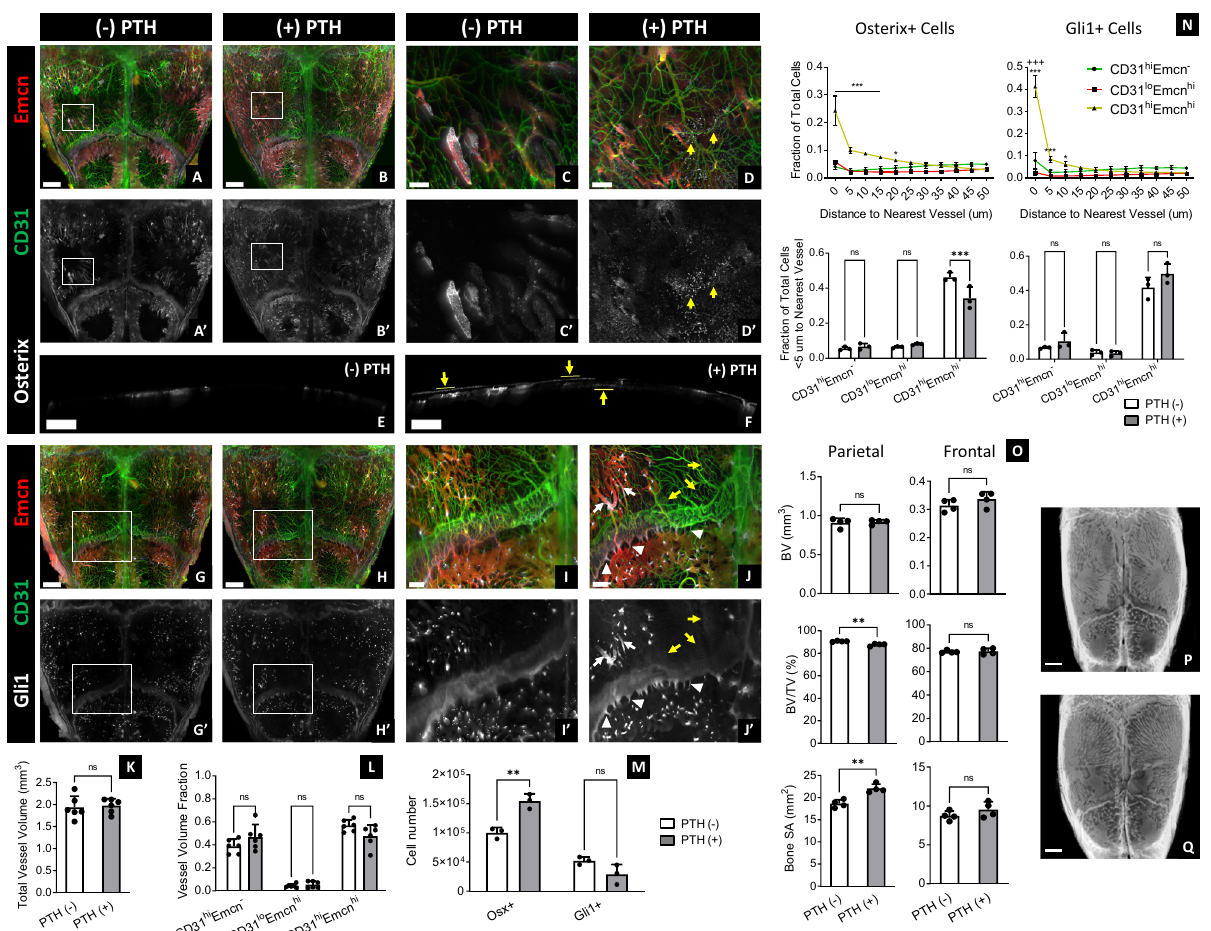
Fig. 4 PTH administration increases the number of Osterix + progenitors, but does not signi fi cantly affect Gli1 + progenitor number or CD31 hi Emcn hi vessel volume. A – D MIP of calvarial vessels ( A – D ) and Osterix + progenitors ( A – D , A ’ – D ’ ) in 12-weeks-old mice with ( B , B ’ , D , D ’ ) or without ( A , A ’ , C , C ’ ) 4 weeks of PTH administration. Increased Osterix + cells are present within the periosteum and dura mater of PTH-treated calvaria (yellow arrows). E – J 40- μ m-thick sagittal sections demonstrating the expansion of Osterix + progenitors in the periosteum and dura mater (yellow arrows) in PTH-treated calvaria ( E ) compared to the control ( F ). G – J MIP of calvarial vessels ( G – J ) and Gli1 + skeletal progenitors ( G – J , G ’ – J ’ ) in control ( G , G ’ , I , I ’ ) and PTH- treated ( H , H ’ , J , J ’ ) groups. More Gli1 + cells are observable in the marrow cavities nearby the transcortical canals (white arrows), as well as in the transcortical canals (white arrowheads) and periosteum (yellow arrows) nearby the sutures in PTH-treated calvaria. Results were replicated in 3 calvaria for each experimental group and staining combination (12 total calvaria). K – M Total vessel volume ( K ), fractional vessel phenotype volume ( L ), and skeletal progenitor number ( M ) in control and PTH-treated calvaria ( n = 3 for M ; n = 6 for K , L ). N Plots representing the spatial correlation of Osterix + and Gli1 + progenitors to vessel phenotypes ( n = 3). Both cell types maintain a preferential relationship with CD31 hi Emcn hi vessels following PTH treatment, but fewer Osterix + cells are associated with CD31 hi Emcn hi vessels compared to control calvaria. O MicroCT quanti fi cation of bone volume (BV), bone volume to tissue volume (BV/TV) percentage, and bone surface area (SA) in the parietal and posterior frontal bones of control and PTH- treated calvaria ( n = 4). P , Q MicroCT 3D volume projections of control ( P ) and PTH-treated calvaria ( Q ). Data are mean ± SD. Statistics were performed using a two-way ANOVA with Bonferroni post-hoc test ( L – N ) or two-tailed t -test ( K , O ). *** p < 0.001, ** p < 0.01, * p < 0.05 where designated or between CD31 hi Emcn hi and CD31 hi Emcn − vessels in N ; +++ p < 0.001 between CD31 lo Emcn hi and CD31 hi Emcn − vessels ( N ). Exact p -values for two-tailed t -tests: K p = 0.7493, O p = 0.7771 (top left), 0.2299 (top right), 0.0021 (middle left), 0.7862 (middle right), 0.0021 (bottom left), 0.2111 (bottom right). Scale bars: 1000 μ m ( A , B , G , H , P , Q ); 700 μ m ( E , F ); 300 μ m ( I , J ); 200 μ m ( C , D ). Colors: Red: Endomucin (Emcn), Gray: Osterix ( A – F ) or Gli1 ( G – J ), Green: